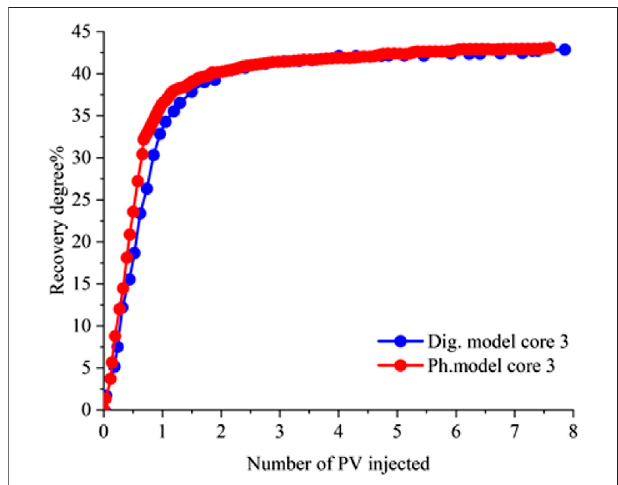
FIGURE 6 | Characteristics of physical model and digital model extraction